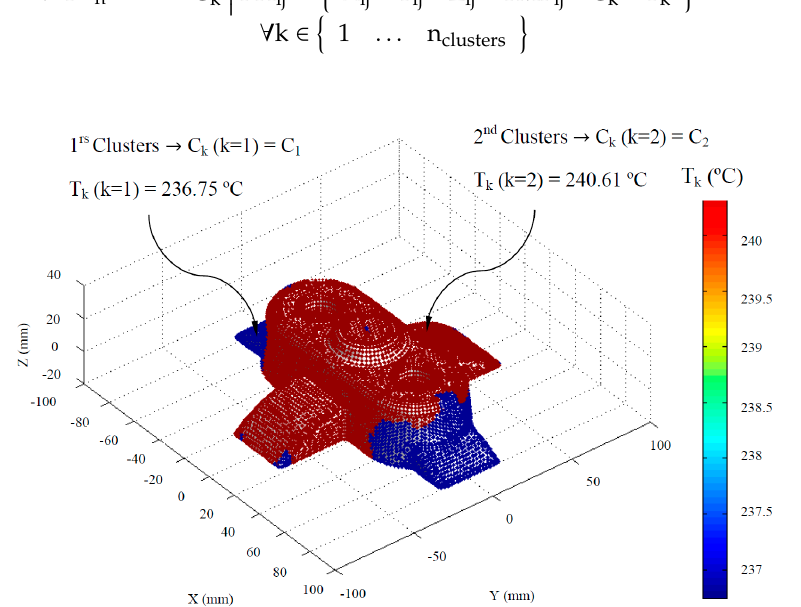
Figure 7. Definition of the geometrical discretizations or clusters of the plastic part.